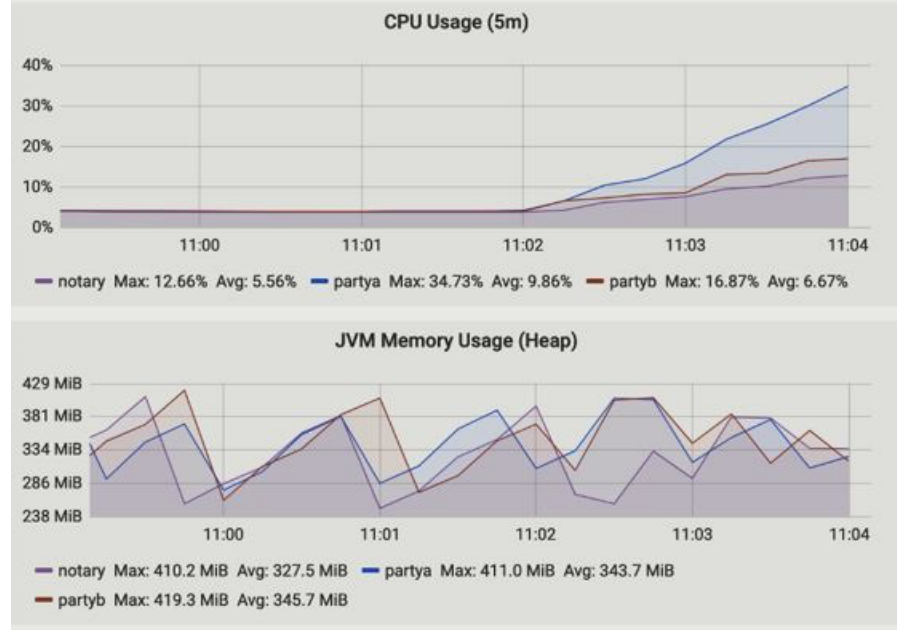
Figure 6. CPU and JVM heap memory usage at time t1 = 15 min.